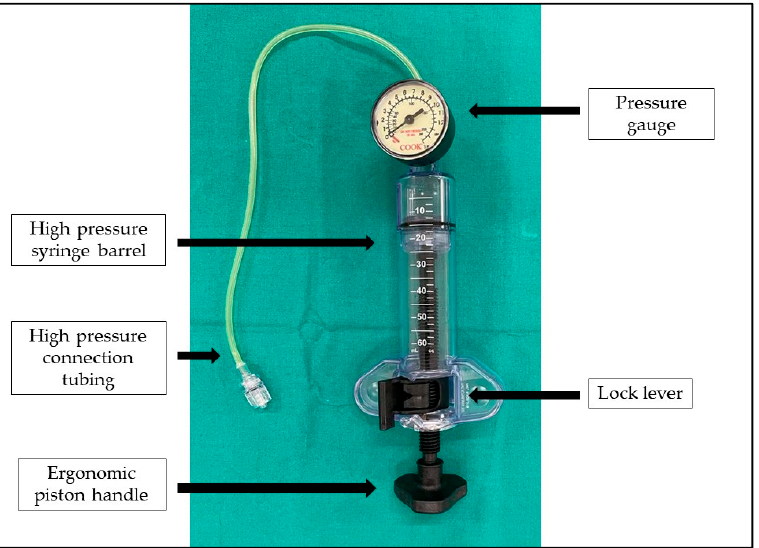
Figure 1. The irrigation device consists of a high-pressure syringe barrel, a lock lever, an ergonomic piston handle, a gauge used to monitor the inflation and deflation of balloon catheters, and connection tubing.